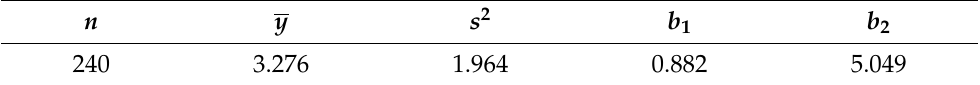
Table 5. M-Sweet: Descriptive statistics.